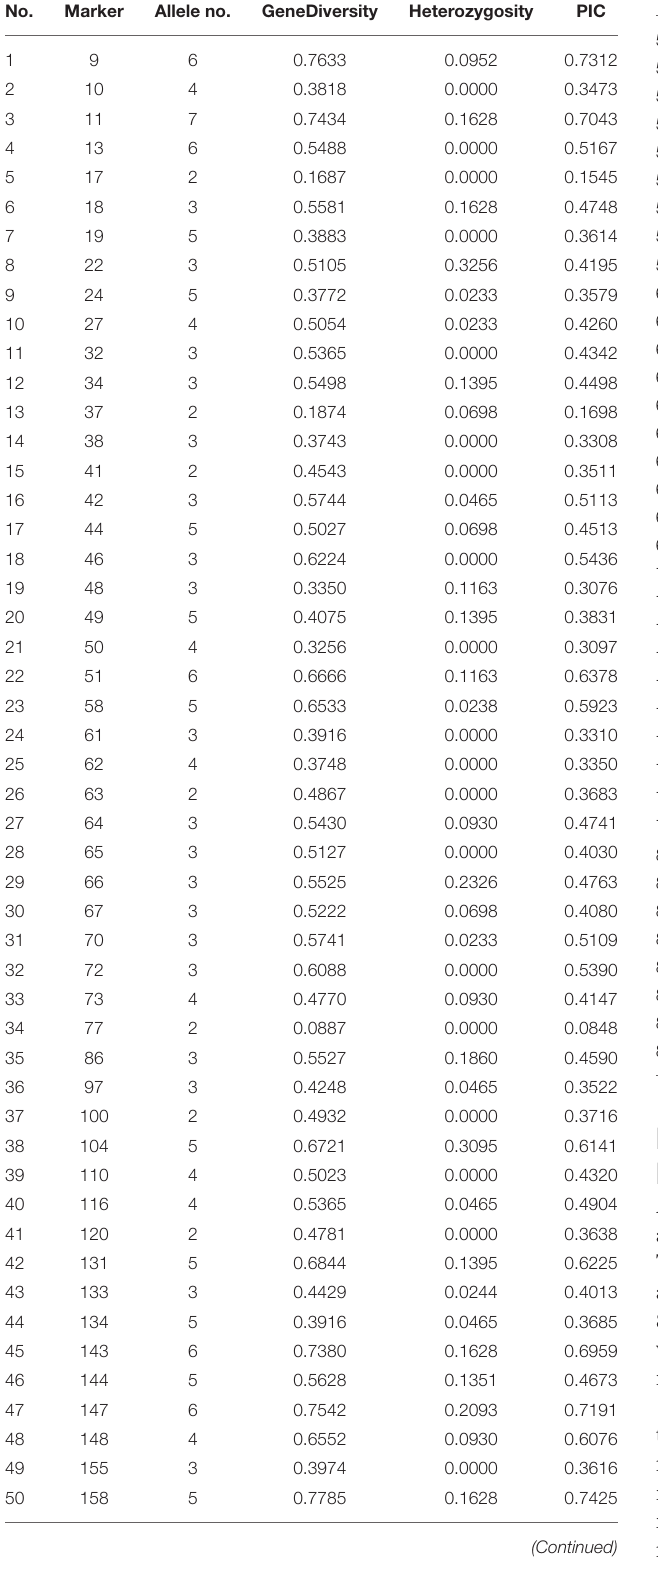
TABLE 2 | Results of 87 effective primers screening in 43 accessions of Lathyrus sativus L. No. Marker Allele